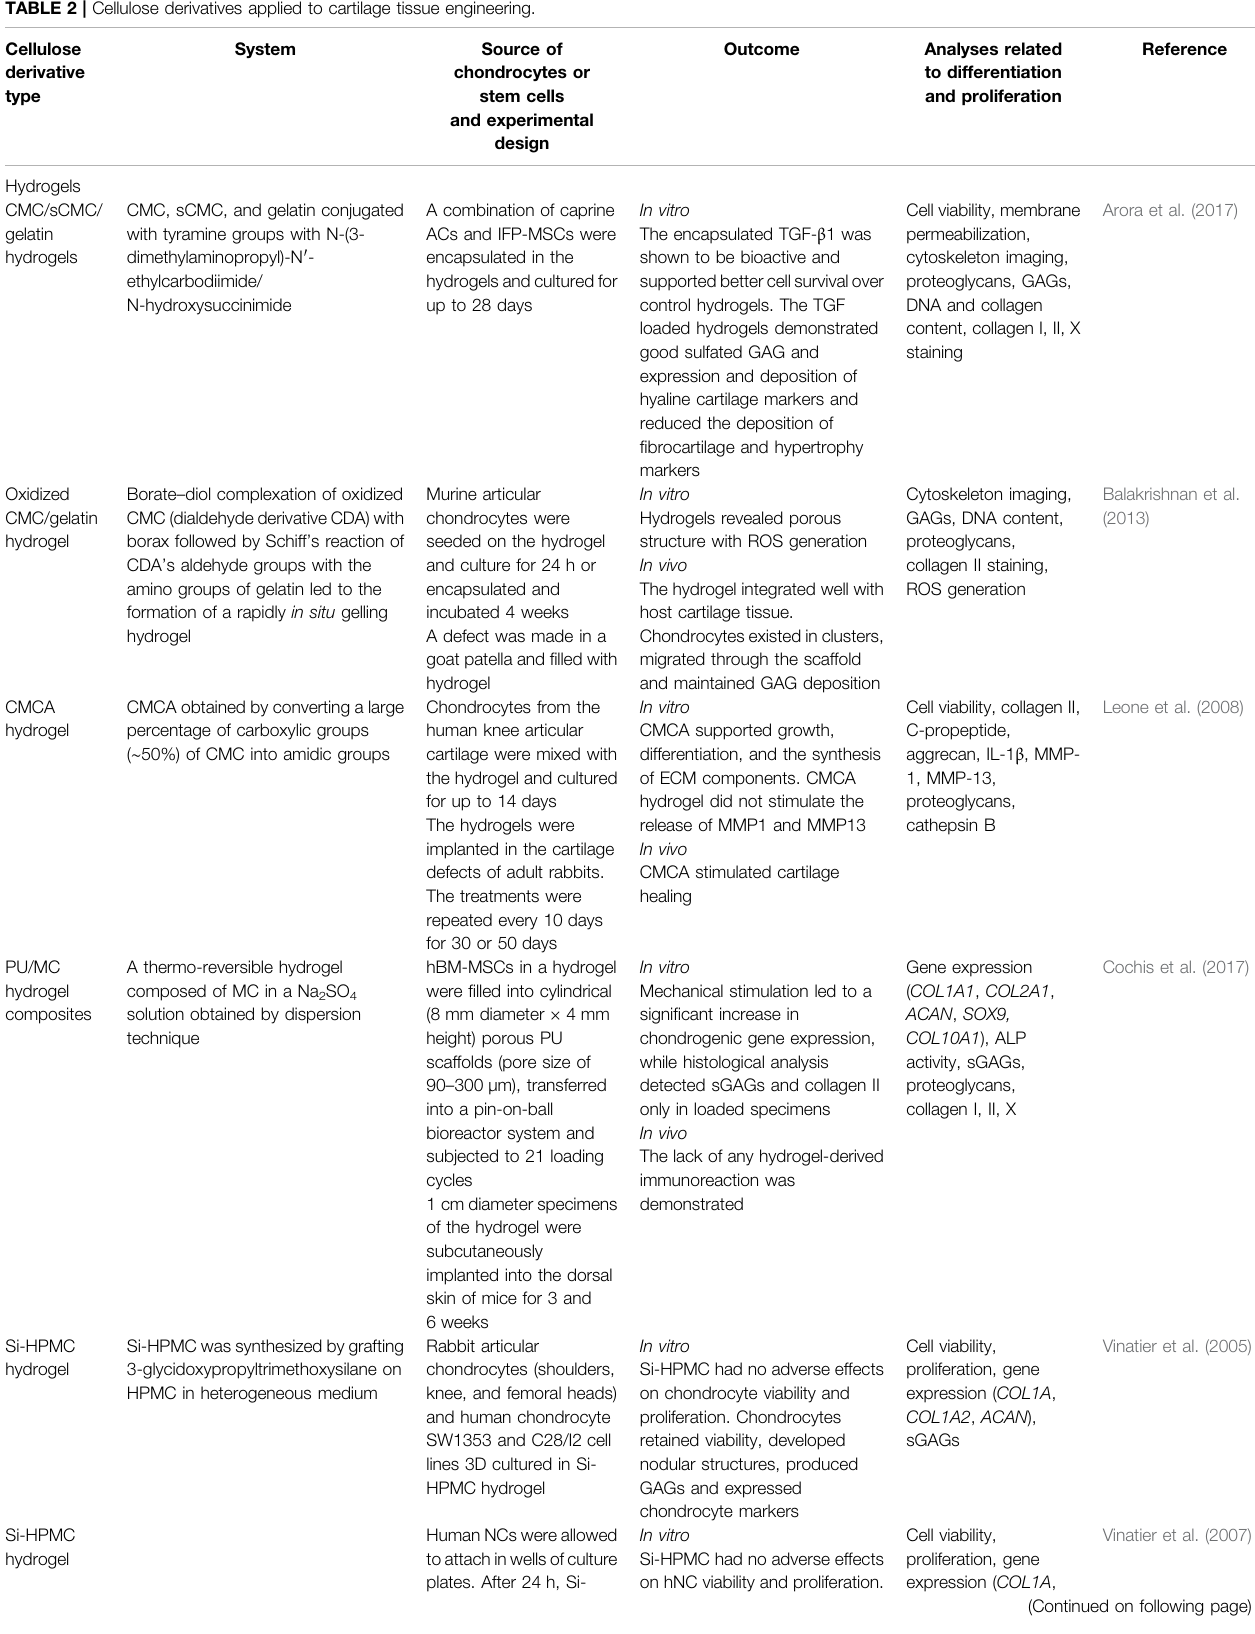
TABLE 2 | Cellulose derivatives applied to cartilage tissue